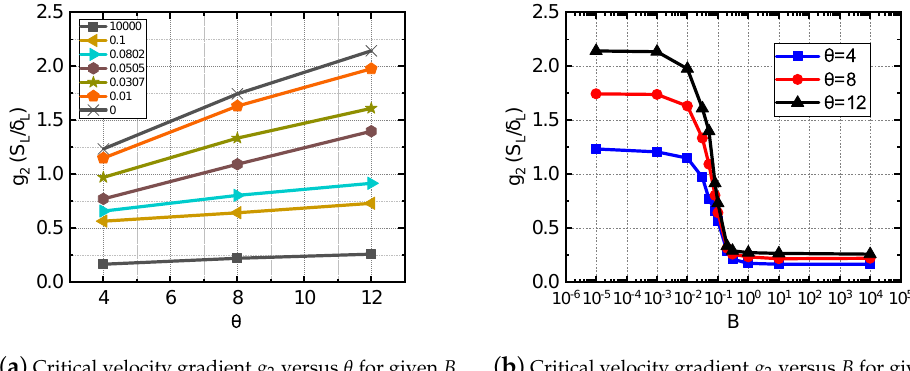
Figure 13. The influence of wall thermal condition ( B = 0,0.01, · · · ,10 4 ) and thermal gas expansion ( θ = 4,8,12) on the critical velocity gradient g 2 ( R = 60 δ L